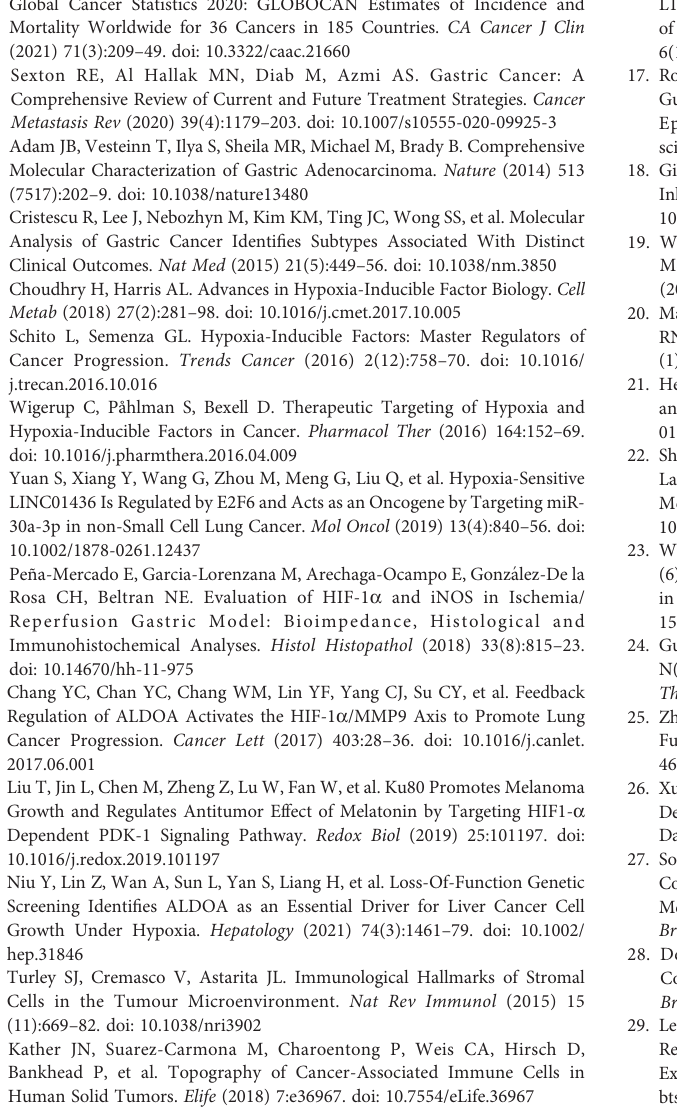
boxplot. (E) the heatmap was drawn to display the relationship of 23 m6A regulators and m6A clusters. (F – H) The different subtypes proportion of (F) Singapore patient cohort subtype, (G) ACRG subtype and (H) hypoxiaCluster showed speci fi c connection with m6A clusters. Supplementary Figure 3 | Further analysis on m6Ascore and validation of the signature and nomogram. (A) .Relationship between m6Ascore and tumor microenvironmentburden(TMB)wasplottedafterstudent-ttest,andr Person was-0.50 and CI 95% [-0.58, -0.42]. (B) The waterfall plot depicted tumor somatic mutation with lowm6Ascore.Thenumbersandbarplotontherightshowedthemutationfrequency of each gene and the proportion of each variant type, respectively. (C) Kaplan – Meier curves of TCGA cohort to be for validation. (D) The AUC in TCGA-STAD cohort achieved 0.60 (53.66%-66.89%, 95%CI), 0.65 (57.03%-72.31%, 95%CI), and 0.61 (47.81%-73.75%,95%CI)at3,5,and7yearsrespectively. (E) Differentproportionsof TCGA cohort subtype were in fl uenced by high- and low-risk score. (F) An external validation cohort of GSE28541 showed signi fi cant difference of m6A. (G) the AUC